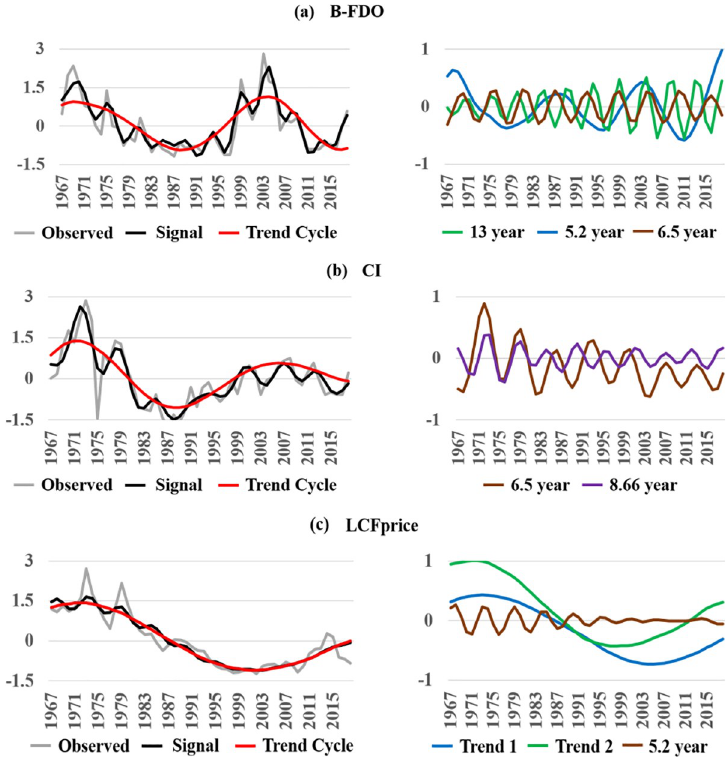
Fig 1. Singular Spectrum Analysis (SSA) of standardized time-series records. Leftward plots show the observed record (grey curve), and the isolated signal (black curve) and low-frequency nonlinear trend components (red curve) for each record. Rightward plots show higher-frequency oscillations. (a)(b) The B-FDO signal (foodborne disease outbreaks attributed to beef) and CI signal (cattle inventory) are dominated by strong multi-decadal nonlinear trend cycles accounting for over 50% of total variation, with higher-frequency 5.2- to 13-year cycles also showing appreciable composite signal strength (Table 1). The nonlinear-trend cycles isolated from the B-FDO record and CI record are strikingly similar. (c) The LCFprice signal (live cattle futures market prices) is dominated by a multi-decadal nonlinear trend cycle accounting for 86% of total variation with a faint higher-frequency 5.2-year cycle accounting for 4% (Table 1). The multi-decadal nonlinear trend cycle is the sum of two independent trend cycles shown in the rightward panel (blue and green curves).